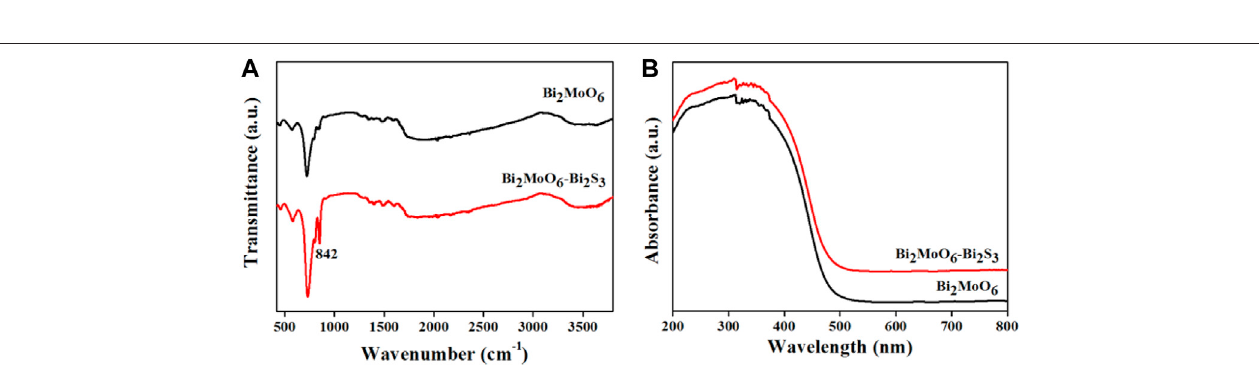
FIGURE 3 | FT-IR spectra of Bi 2 MoO 6 and Bi 2 MoO 6 – Bi 2 S 3 (A) ; UV-vis DRS of Bi 2 MoO 6 and Bi 2 MoO 6 – Bi 2 S 3 (B) .